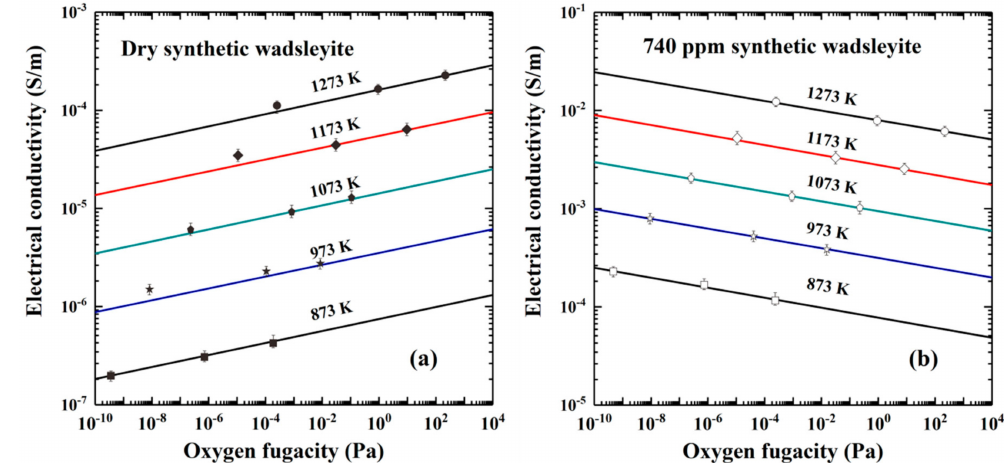
Figure 11. The influence of oxygen fugacity on the EC of ( a ) dry and ( b ) water-rich wadsleyite aggregates (740 ppm) under conditions of 15 GPa and 873–1273 K. Oxygen fugacity is controlled by three solid bu ff ers, i.e., Mo–MoO 2 , Ni–NiO and Re–ReO 2 (Reproduced with permission from Dai and Karato, Earth Planet. Sci. Lett.; published by Elsevier, 2009